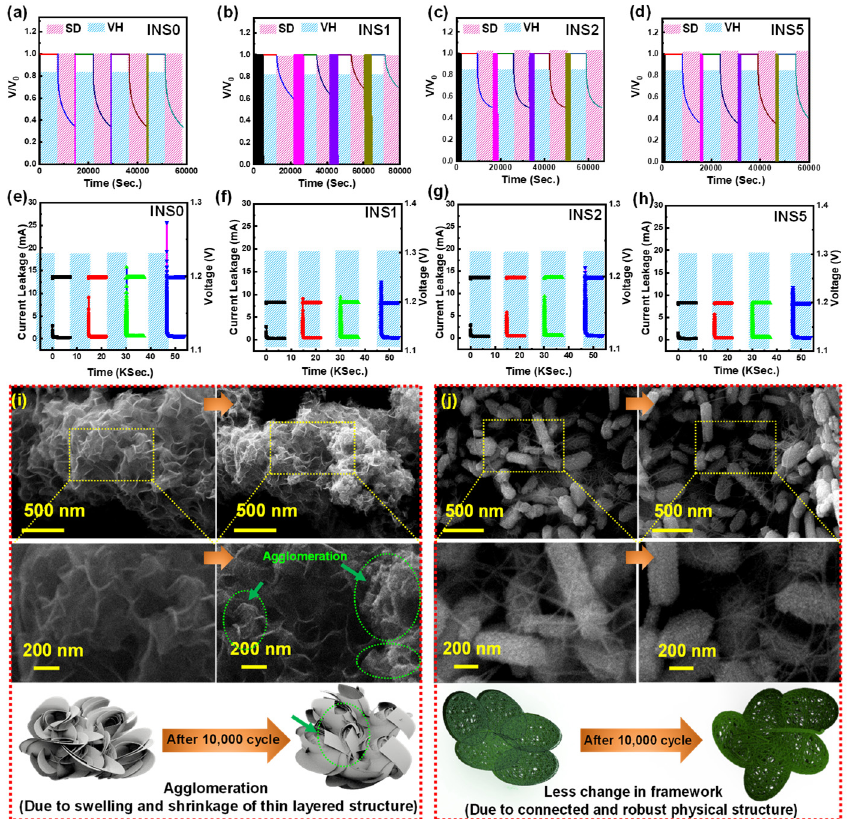
Figure 6. ( a – d ) GCD (100 cycles) + VHT (2 h) + SD (2 h), ( e – h ) leakage current during voltage holding. ( i , j ) FESEM images test of INS0 and INS5 before and after 10,000 cycle stability tests.